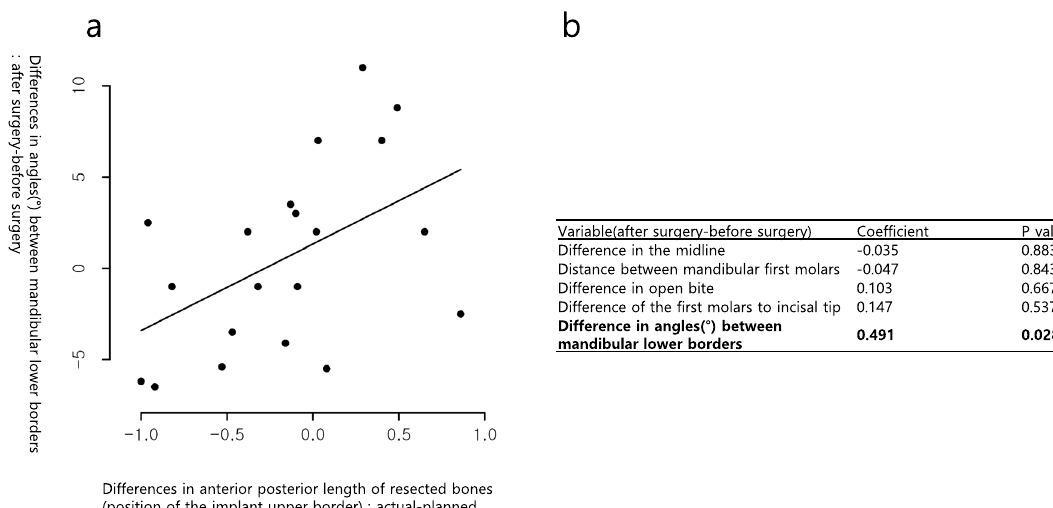
Fig. 9 Analysis of correlation between pre- and postoperative length differences. Analysis of correlation between length differences in anteroposterior lengths of resected bones (upper borders) and angle differences in mandibular lower borders pre- and postoperatively